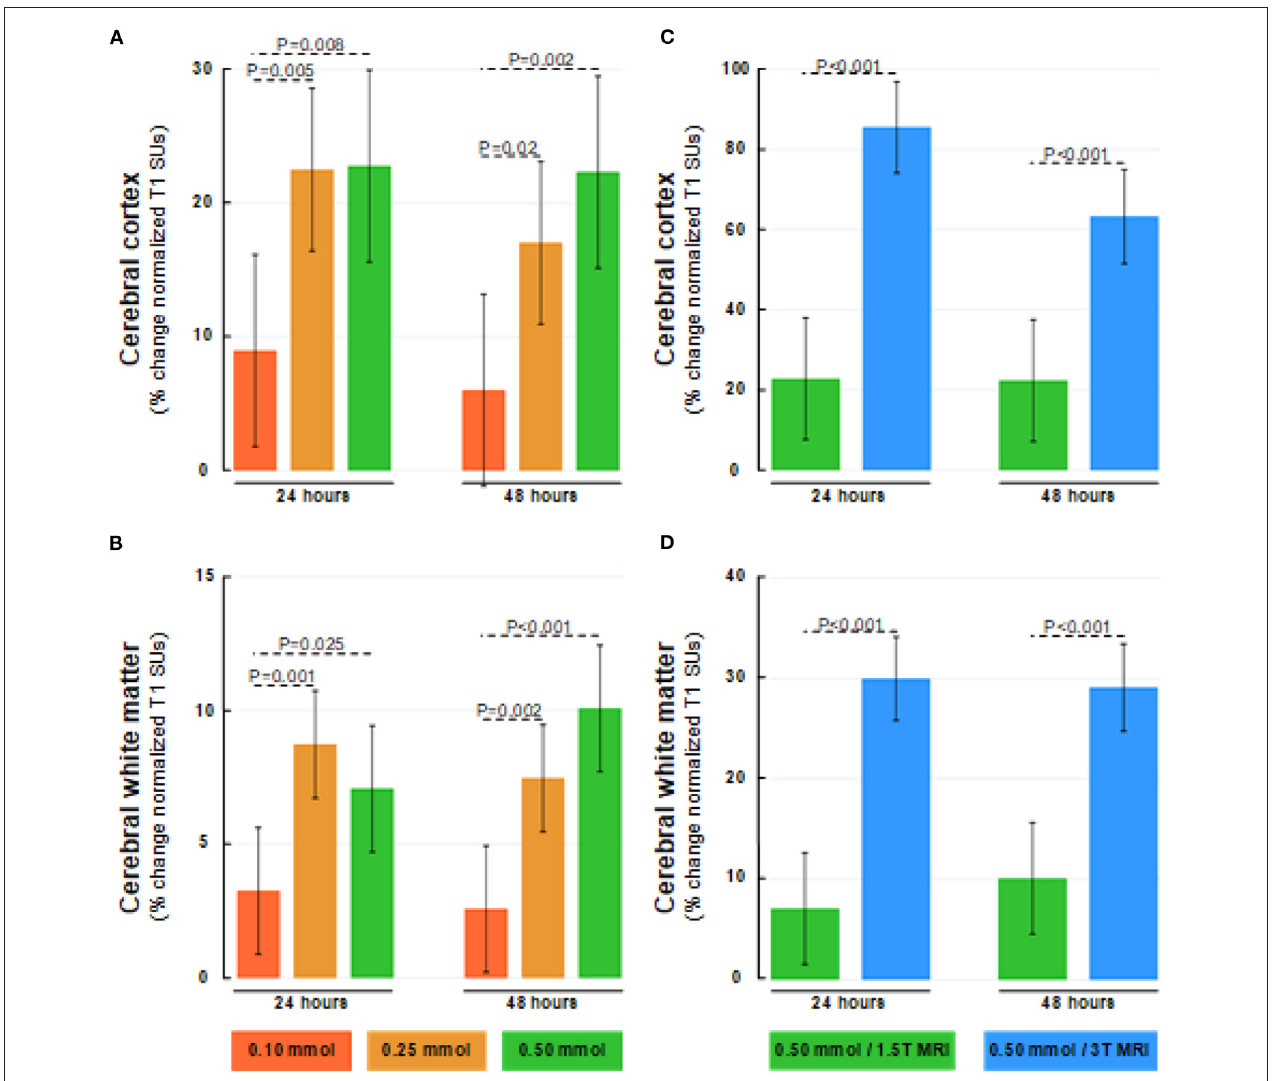
FIGURE 8 | Dose-dependent percentage changes in normalized T1 signal (1.5T MRI scanner) after 24 and 48h within (A) cerebral cortex (gray matter), and (B) cerebral white matter after intrathecal gadobutrol in doses of 0.10 mmol (red bars), 0.25 mmol (orange bars), and 0.50 mmol (green bars). The percentage change in normalized T1 signal at 24 and 48h after intrathecal gadobutrol (0.50 mmol) within (C) cerebral cortex (gray matter), and (D) cerebral white matter are shown for 1.5T (green bars) and 3T MRI scanners (blue bars). The bars show mean and 95% CIs. Differences between groups were determined by mixed model